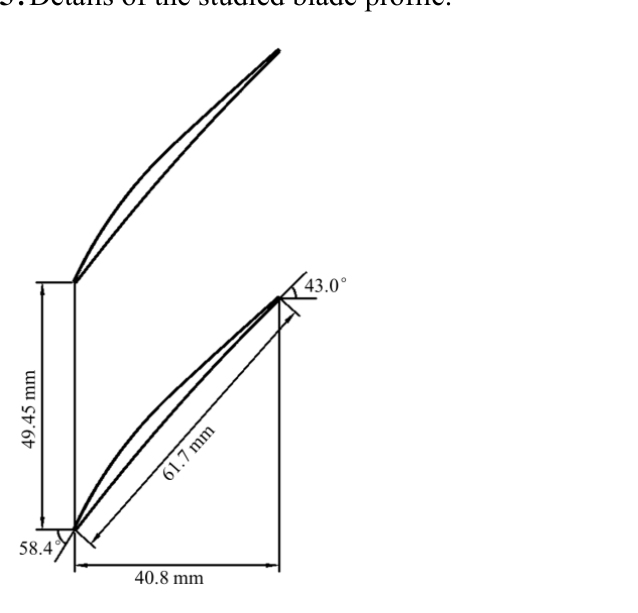
Figure 5. Details of the studied blade